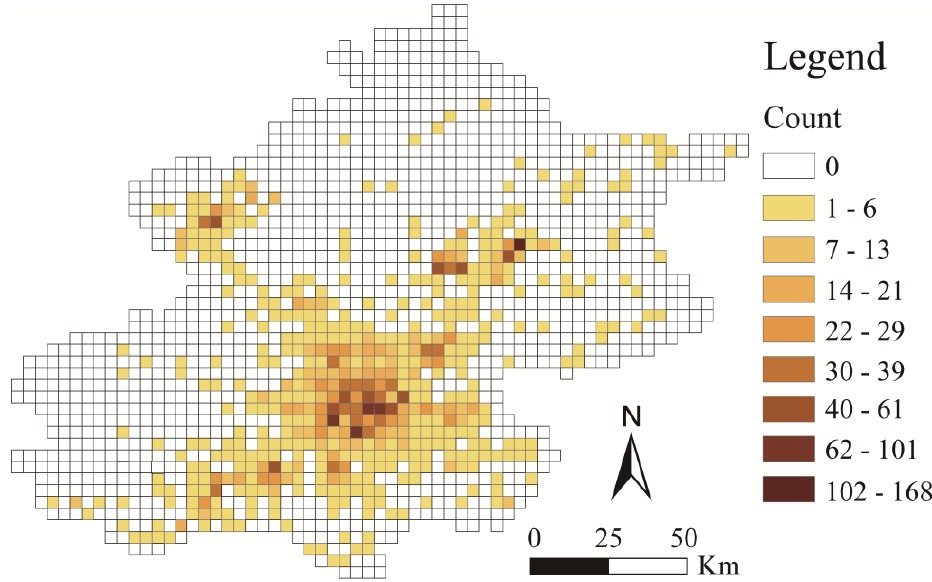
Figure 10. The heat map of POI distribution expressed by the 14th level grid of GeoSOT grid.